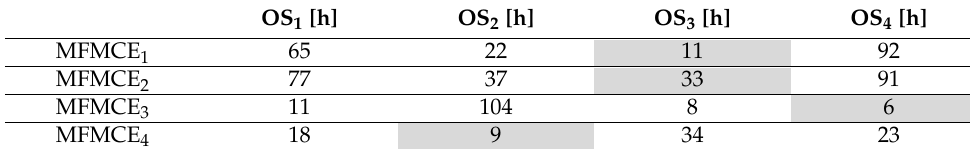
Table 1. Cross combination of MFMCEs and the time necessary for operation sequences.